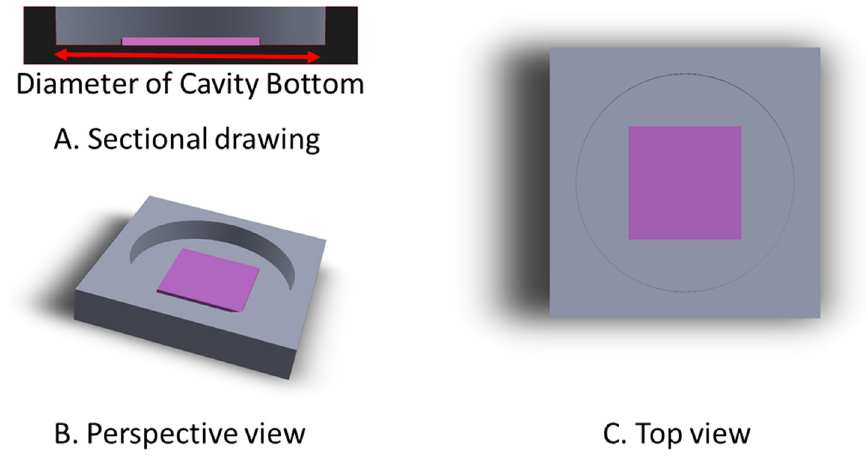
Figure 4. 3D model of a DUV-LED’s cavity.